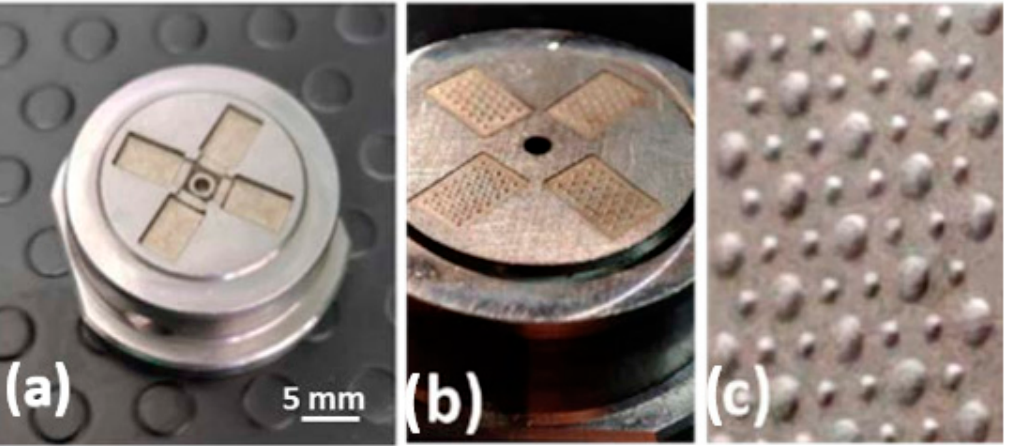
Figure 7. Mold inserts. ( a ) Cavities insert, ejection side; ( b ) micro-textured insert, injection side; ( c ) detail of domes.